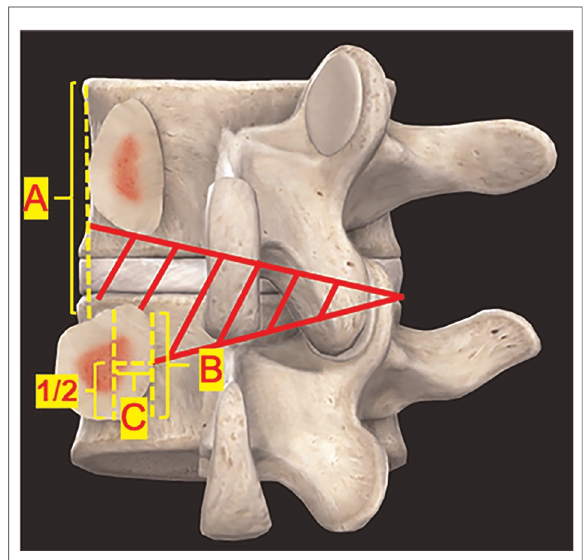
FIGURE 1 Secompression range of unilateral biportal endoscopy. ( A ) Outer border of the pedicle; ( B ) Inner edge of pedicle; ( C ) Midline border of the pedicle. The contralateral decompression extent (red area). Lateral recess decompression should reach half of the medial border of the pedicle ( C ), and the foraminal decompression should reach the outer border of the pedicle ( A